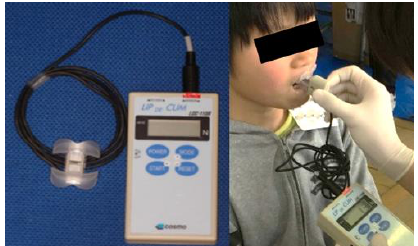
Figure 9. Lip closure force measurement. The lip closure force was measured using a Lip de Cum ® LDC-110R (Cosmo Instruments Co., Ltd., Tokyo, Japan). The subjects were seated with the Frankfurt horizontal plane parallel to the floor. Duckling lip holders were placed between the lips and the maximum lip closure force was measured in the intercuspal position.